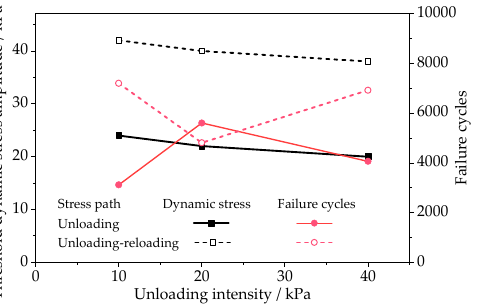
( c ) Figure 12. Excess pore water pressure under unloading stress path. ( a ) BU − 1 (unloading intensity = 10 kPa); ( b ) BU − 2 (unloading intensity = 20 kPa); ( c ) BU − 3 (unloading intensity = 40 kPa). 0 ( c ) Figure 13. Excess pore water pressure under unloading and reloading stress path. ( a ) CU − 1 (un ‐ loading intensity = 10 kPa); ( b ) CU − 2 (unloading intensity = 20 kPa); ( c ) CU − 3 (unloading intensity = 40 kPa). 5. Conclusions In order to evaluate the long ‐ term deformation of the silt around the existing tunnel under the unloading of the above foundation pit and the cyclic loading of metro trains, a